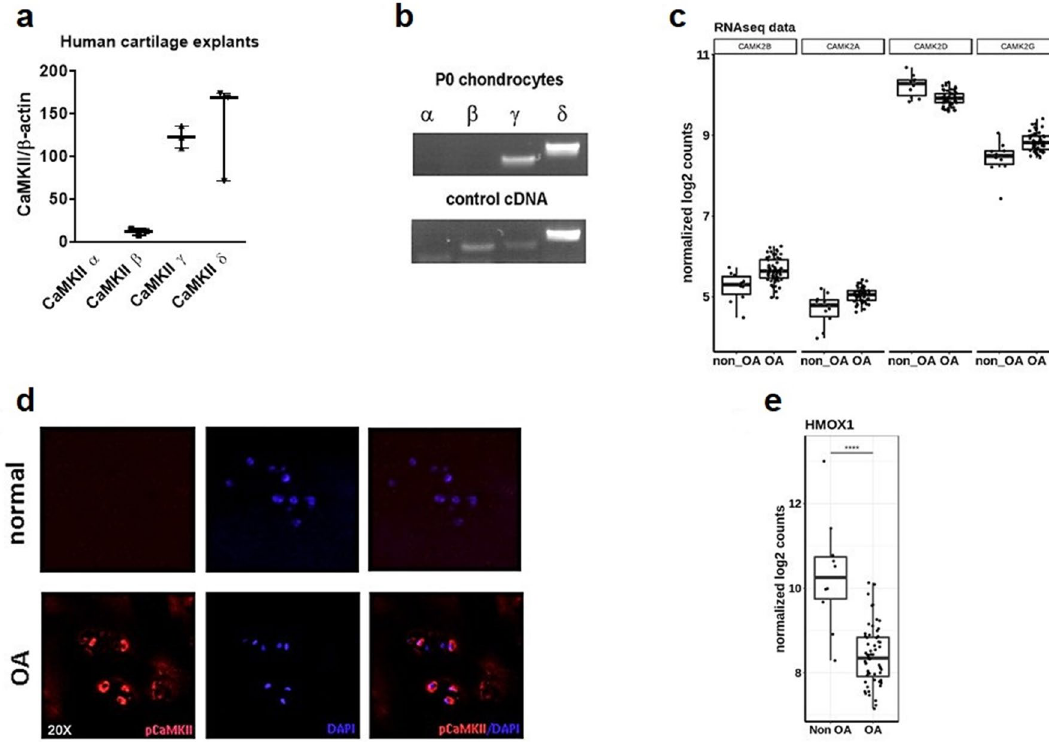
Figure 2. CaMKII and HMOX1 expression are oppositely modulated in osteoarthritis. ( a ) Relative expression of the four CaMKII mRNA isoforms as assessed by expression microarrays in human cartilage explants 6 . ( b ) Gene expression analysis by semiquantitative PCR for CaMKIIα, -β, -γ, -δ , in P0 human articular chondrocytes (upper row). A pool of cDNA from brain, placenta and lymph node was used as positive control for the PCR (lower row) (n cycles = 40). All the samples were loaded and run in the same gel whose image was cut for best rendering. A picture of the full original gel can be found in Supplementary Figure 3. ( c ) RNA expression of CaMKII isoforms in human cartilage retrieved from normal and OA human cartilage as assessed by Soul and colleagues in a previously performed RNAseq 27 . ( d ) Immunodetection of phospho-CaMKII in normal and OA articular cartilage. Image representative of n = 3. ( e ) RNA deep sequencing analysis of HMOX1 expression in normal and OA articular